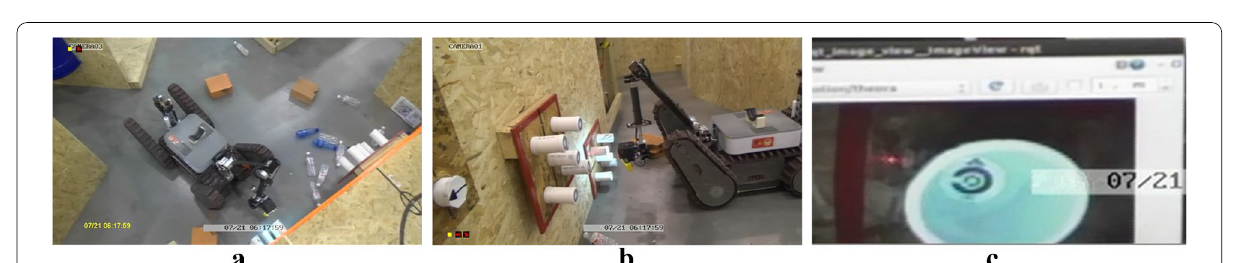
Fig. 22 Karo is inspecting inside parallel pipes of Dexterity test suite